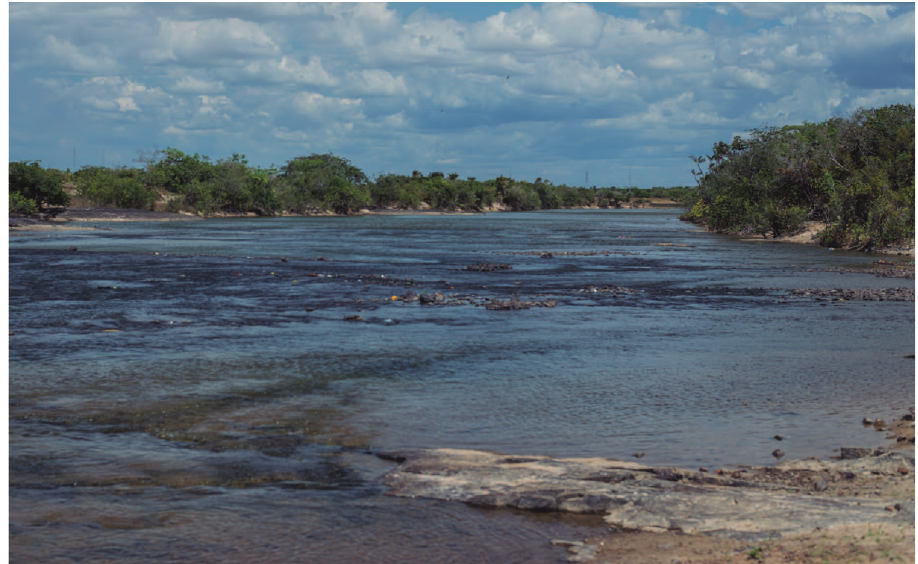
Figure 8. General aspect of the Cauamé River, Roraima, Brazil.